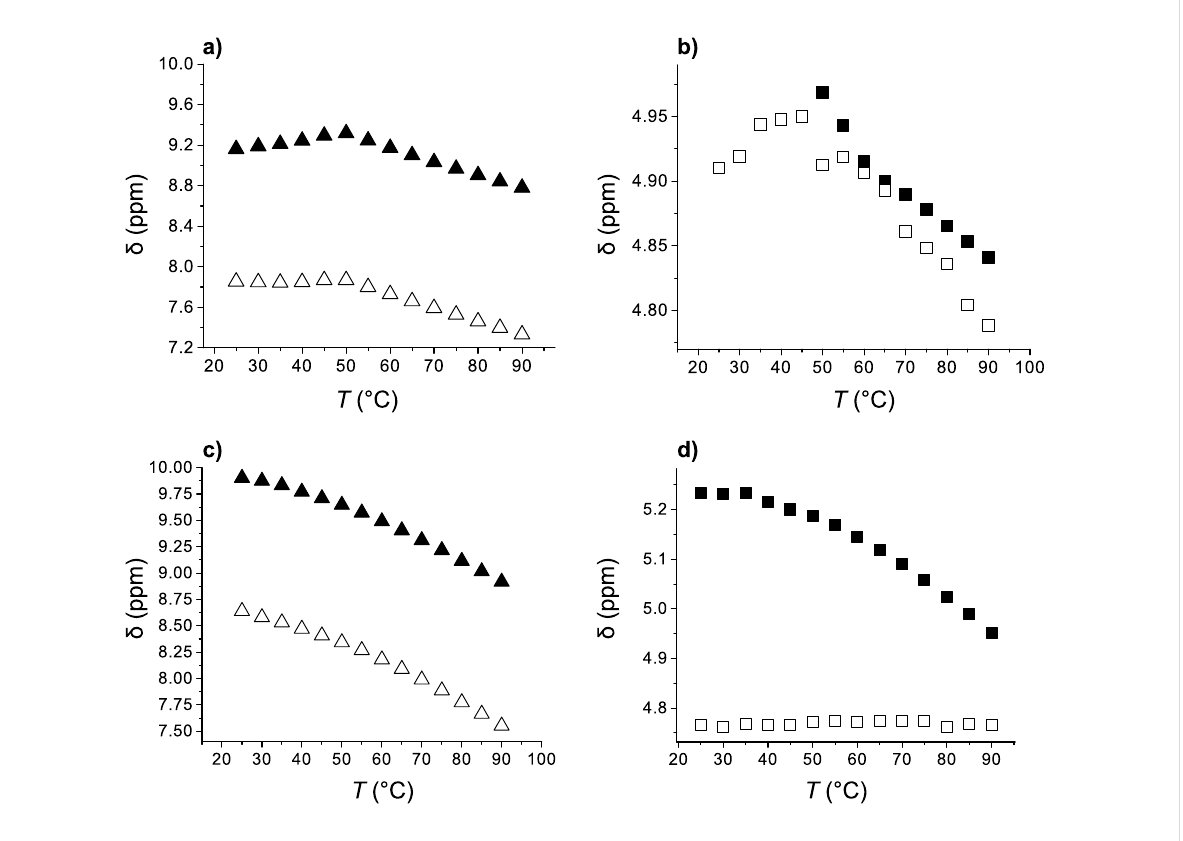
Figure 7: Temperature dependence of: a) oxalamide NH protons ( ▲ ), Leu-NH protons ( Δ ) and b) oxalamide- α -Leu-C*H ( ■ ) and oxalamide- β -Leu-C*H ( □ ) chemical shifts in 0.5 mol dm − 3 ( S,R )- 1b toluene- d 8 gel sample; c) and d) induced shifts of the respective protons in ( S,S )- 1b toluene- d 8